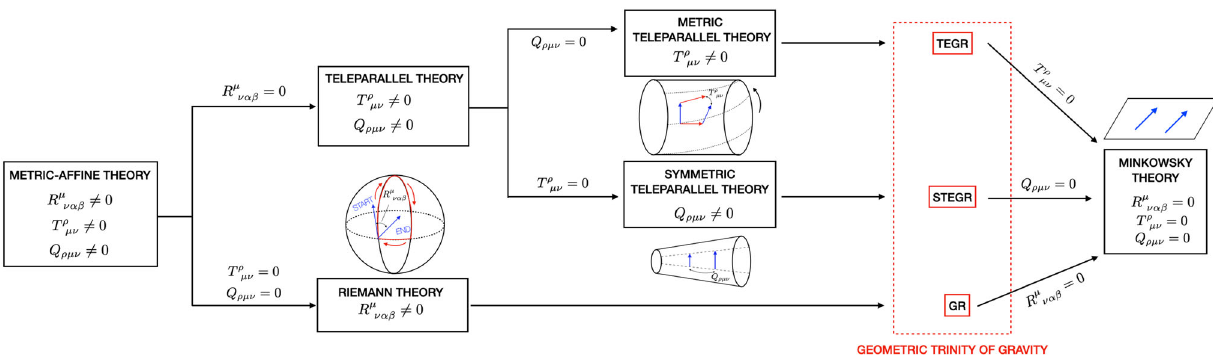
Fig. 2 TheGeometricTrinityofGravityframeworkandthedynamical role of tensor invariants. Curvature rules how the tangent space rolls a curveonamanifold; torsion howthetangentspacetwistsaroundacurve